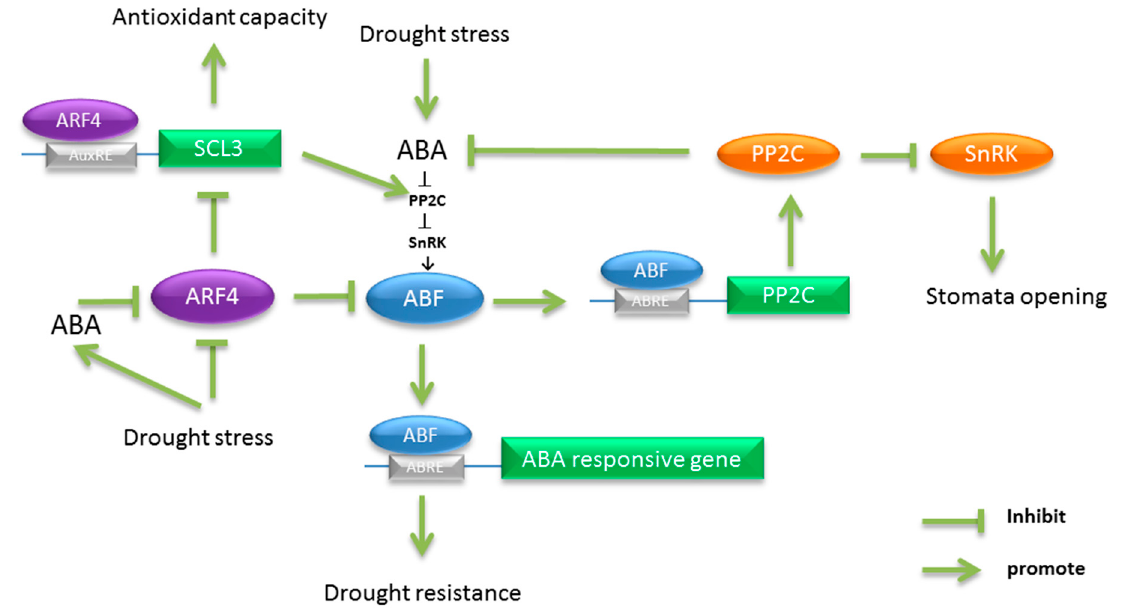
Figure 6. Hypothetical model of SlARF4 participation in ABA signal transduction pathway to regulate resistance to water deficit in tomato plants.